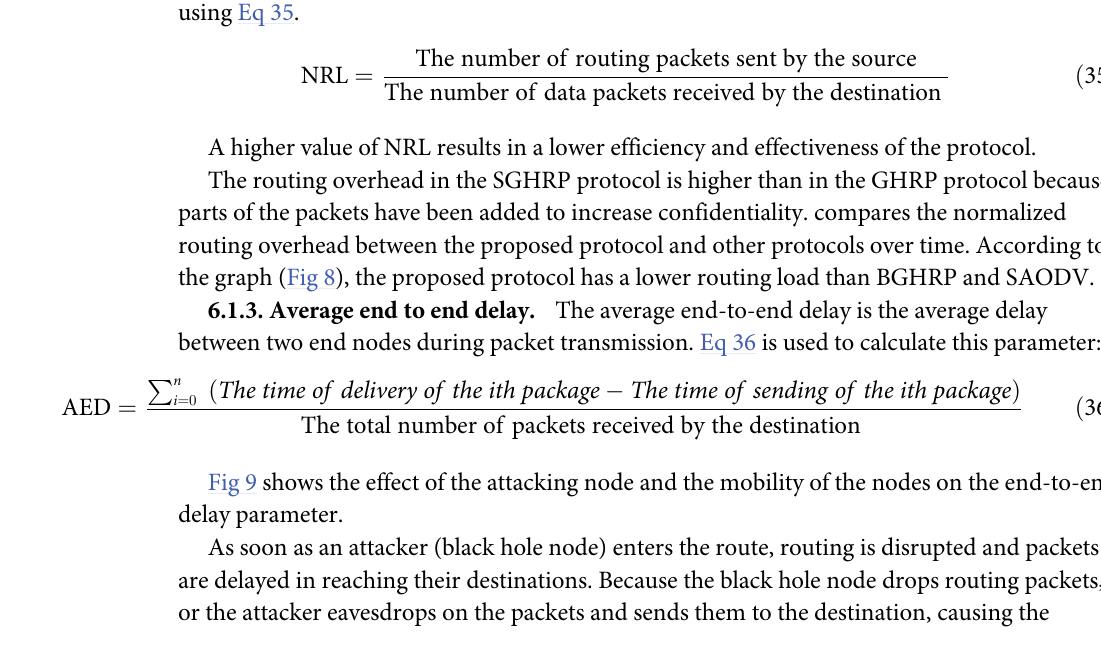
6.1.2. Normalized routing load. A normalized routing load (NRL) is the ratio of routing